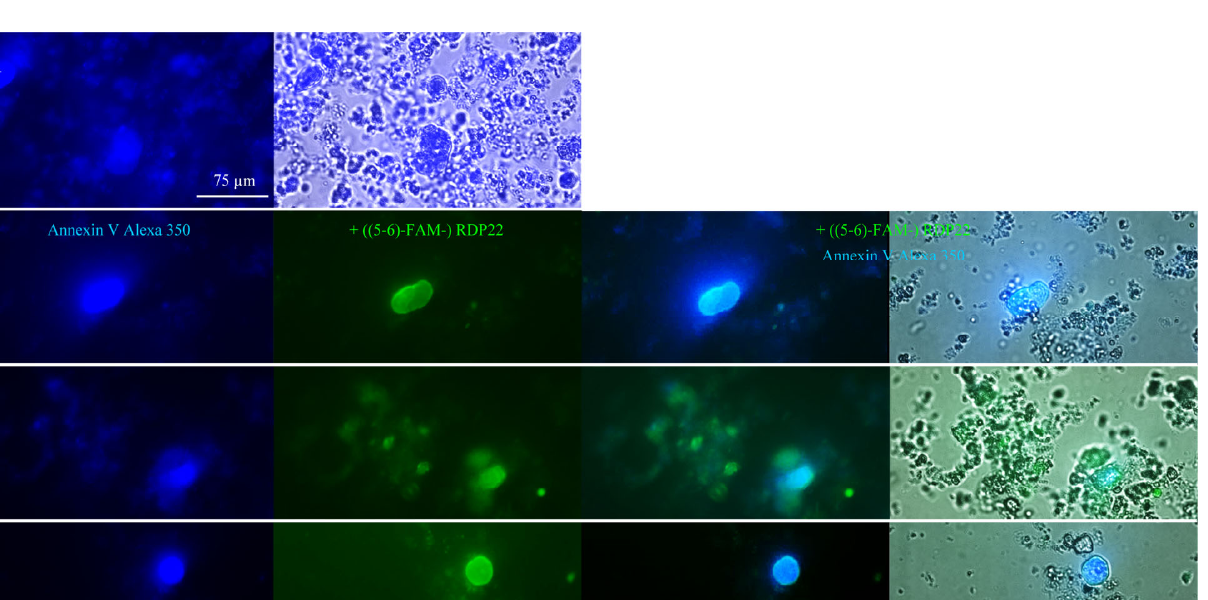
Figure 1. Comparison of PS exposure of normal human dermal fibroblasts (NHDF) with melanoma cell line MUG ‐ Mel2 by measurement of fluorescence of bound Annexin V ‐ Alexa 488. MUG ‐ Mel2 shows significant increase in PS ‐ levels exposed. PI uptake was measured as control to exclude bind ‐ ing of Annexin V to the inner leaflet of plasma membranes due to necrosis. Mean values (black dots) with standard deviations of 4–10 independent experimental data are shown. Respective PS ‐ levels exposed differ significantly (student’s t ‐ test, p < 0.001).